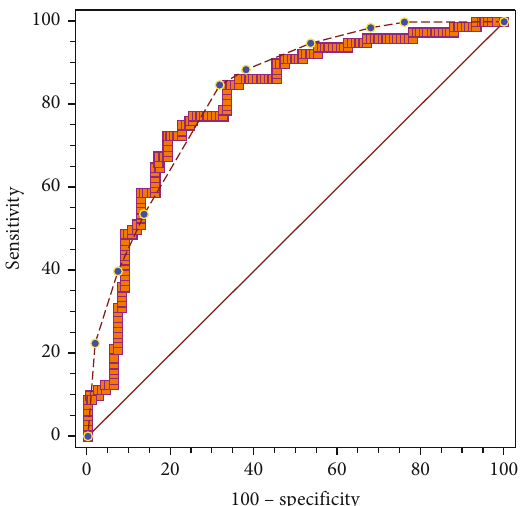
Figure 3: Comparison of the receiver operating characteristic curves between the two models. The red line with blue dots is the curve of the decision tree model, while the orange line is the curve of the logistic regression model. The area under the curve is 0.808 for the logistic regression model and 0.831 for the decision tree model. There are no signi fi cant di ff erences between the two